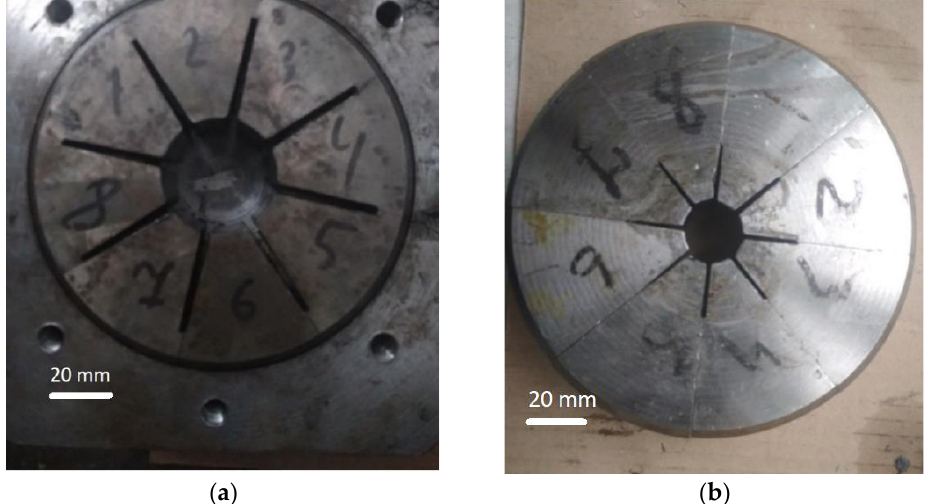
Figure 5. Removable blocks with inserts for the simultaneous extrusion in eight channels with converging angles varying from 0 to 3.5 ◦ and dimension ratios of ( a ) 1 and ( b ) 1/2.